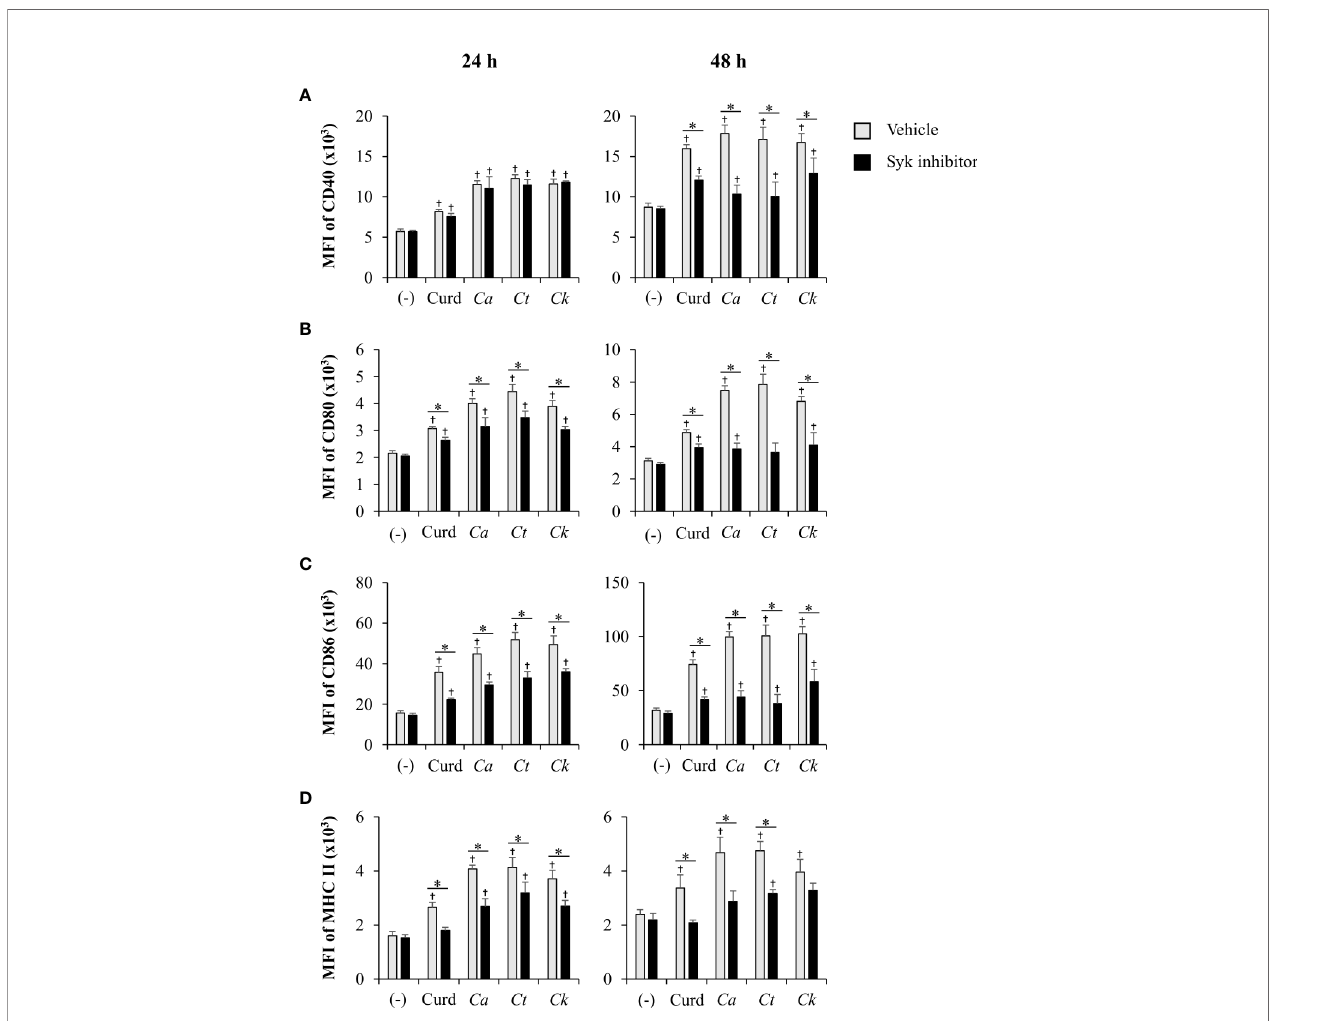
FIGURE 11 | Inhibition of dendritic cell (DC) maturation by Syk inhibitor. Bone-marrow derived DCs (BMDCs) were pre-treated with 1 µM of Syk inhibitor for 30 min, and then the cells were stimulated with 25 µg/ml of curdlan and b -glucans isolated from C. albicans , C. tropicalis , and C. krusei for 24 h and 48 h. The geometric mean fl uorescence intensity (MFI) of DC maturation markers (A) CD40, (B) CD80, (C) CD86, and (D) MHC class II on CD11c + cells were determined using histogram analyses. n = 5; data are representative of two independent experiments. † p < 0.05 compared with unstimulated BMDCs, * p < 0.05. (-), unstimulated BMDCs; Curd, curdlan; Ca , C. albicans ; Ct , C. tropicalis ; Ck , C. krusei